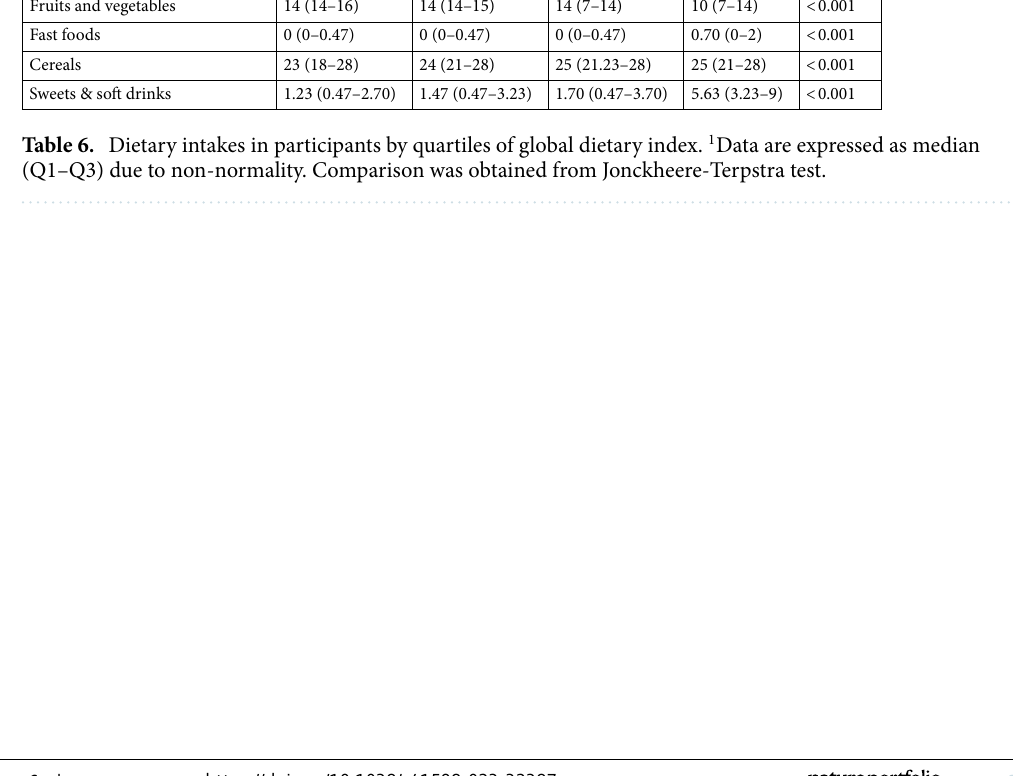
Dietary intakes (times/week)